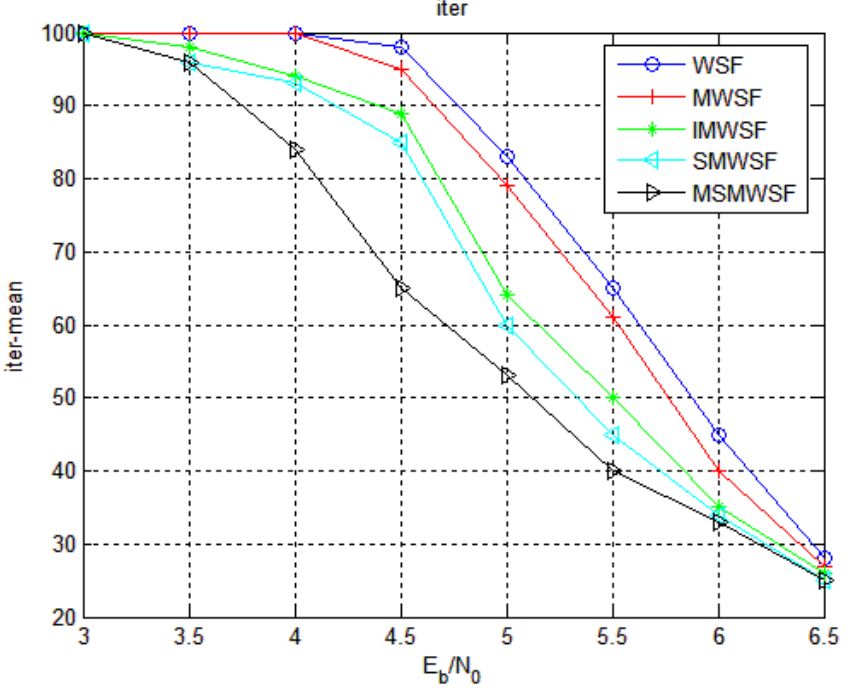
Figure 9. The average number of iterations of five algorithms under Code 1.